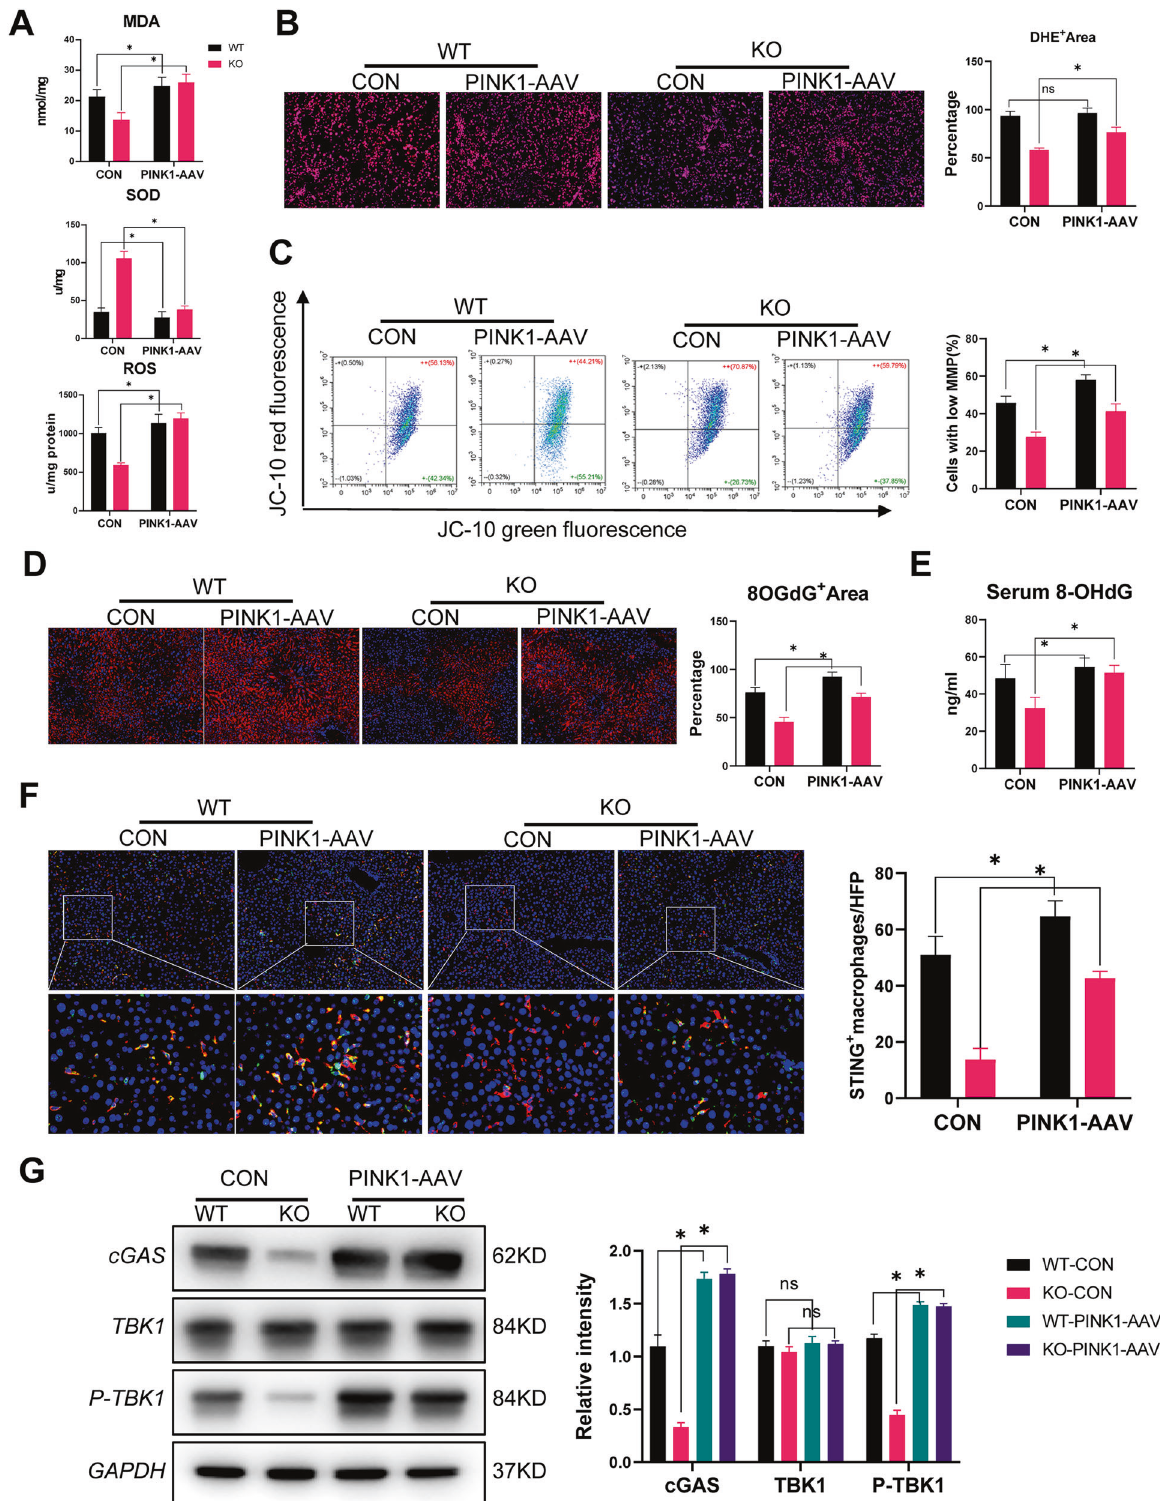
Fig. 6 MLKL de fi ciency suppressed macrophage STING activation and in fl ammatory liver IR injury by activating mitophagy in hepatocytes. WT and MLKL KO were pretreated with AAV-PINK1-shRNA or AAV-CON-shRNA for 2 weeks and subjected to liver IR model. A Levels of MDA, SOD and ROS in liver tissues. B Representative images of DHE (red) staining in liver tissues. C MMP detected by fl ow cytometry analysis of JC-10 in isolated primary hepatocytes. D Immuno fl uorescence staining of DAPI (blue), 8-OHdG (red) in liver tissues. E Serum Levels of 8-OHdG. F Immuno fl uorescence staining of DAPI (blue), F4/80 (red) and STING (green) in liver tissues. G Western blot analysis of cGAS, TBK1, P-TBK1, and GAPDH in isolated intrahepatic macrophages. n = 5 mice/group. All results represent at least two independent experiments. Values were expressed as mean ± SD. * p <